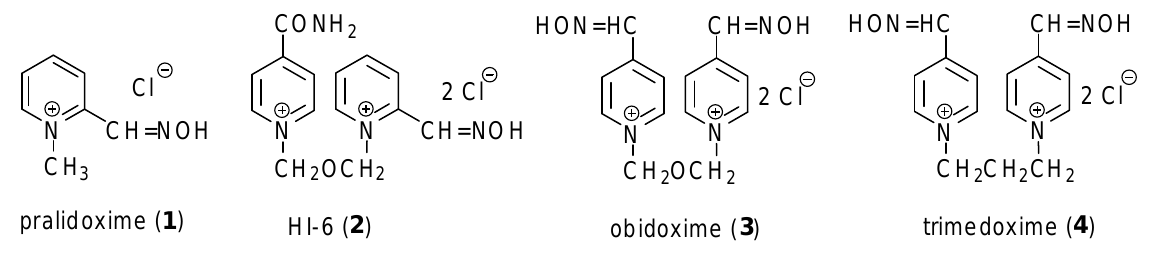
Figure 2. Commercially available oxime